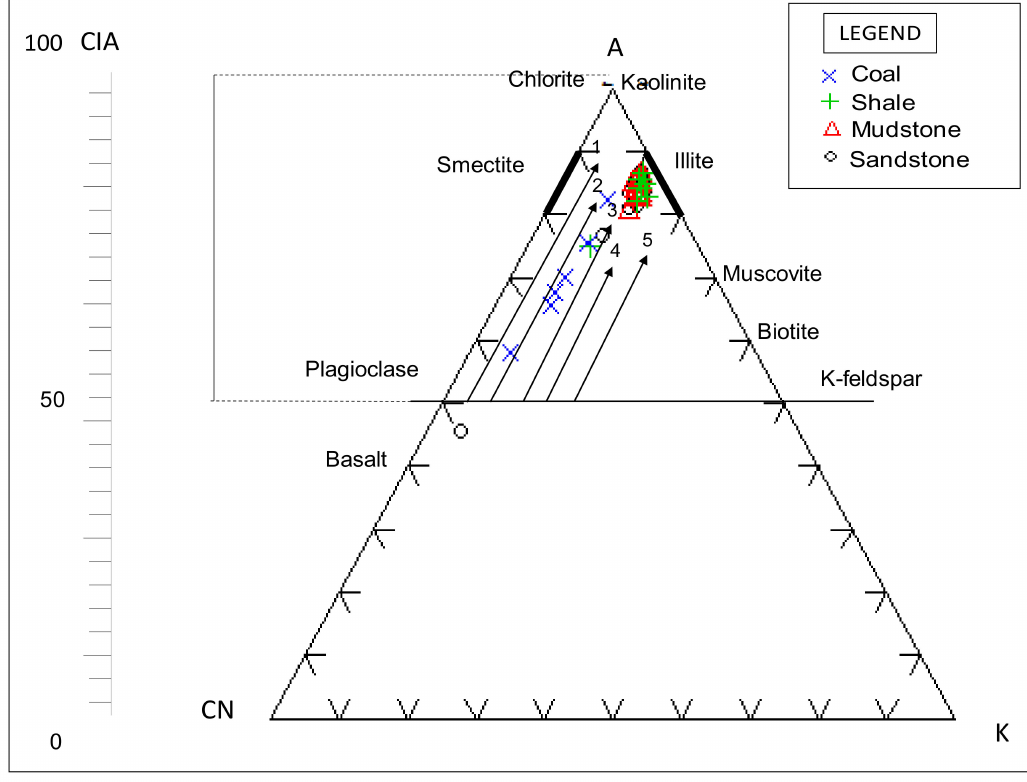
Figure 16. A–CN–K ternary diagram of molecular proportions of Al 2 O 3 –(CaO + Na 2 O)–K 2 O for Bredasdorp mudrocks (Background field after [34]). The CIA scale shown at the left side is for